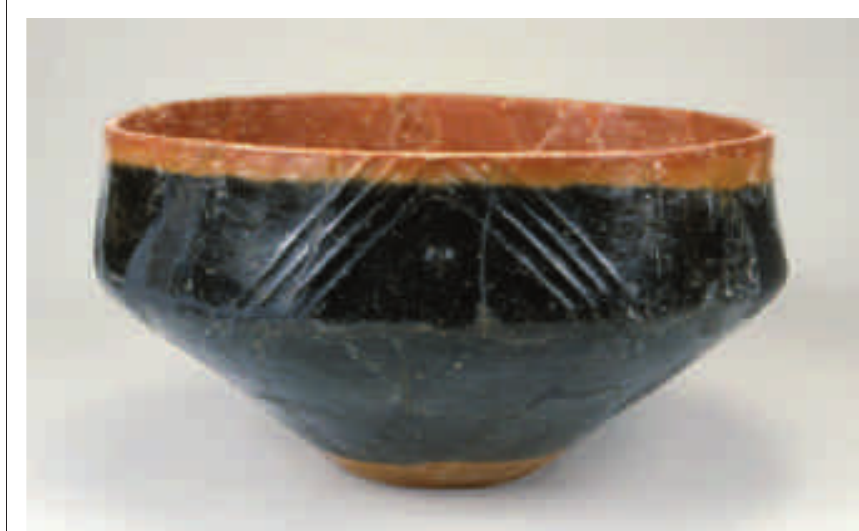
Figure 4 Khirbet Kerak Ware bowl, mid-third millennium BC